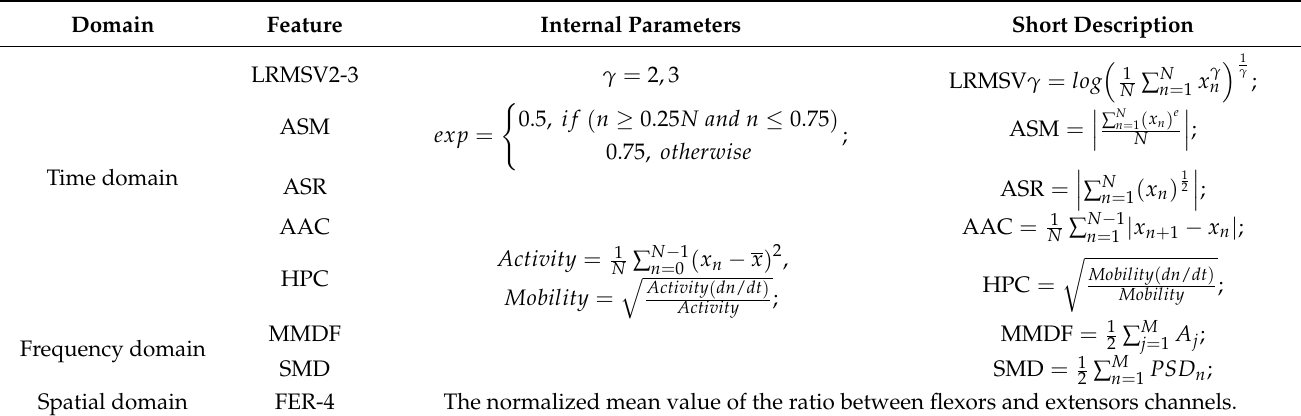
Table 2. Feature additions of the ASF-14NP stroke-oriented multidomain feature set.